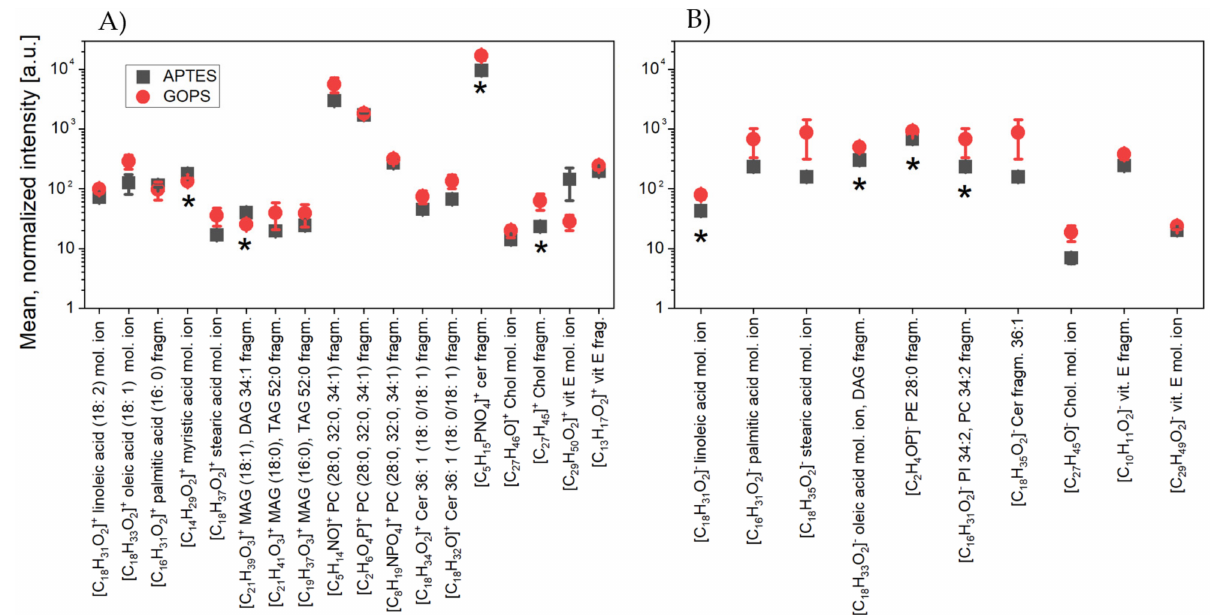
Figure 9. Values of mean normalized intensities for characteristic peaks of lipids in ( A ) positive and ( B ) negative polarity, compared to the used silanes (APTES and GOPS), with uEVs applied to properly functionalized surfaces at a concentration of 3 × 10 9 particles/mL. These data refer to the LACT protein concentration of 25 µ g/mL. The index “*” means a statistically significant difference at the level of p = 0.05 for the studied